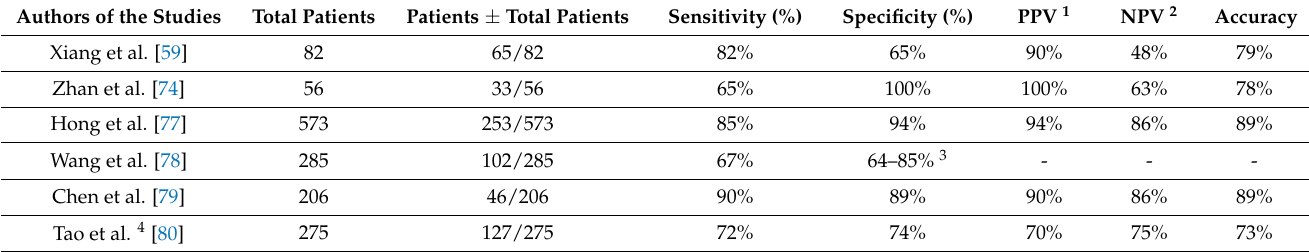
Table 1. Comparison of the papers based on the number of patients included in each single study and on the number of patients with at least one malignant nodule detected using CEUS; the values for sensitivity, specificity, PPV and NPV were obtained though comparison with the histological examination. Authors of the Studies Total Patients